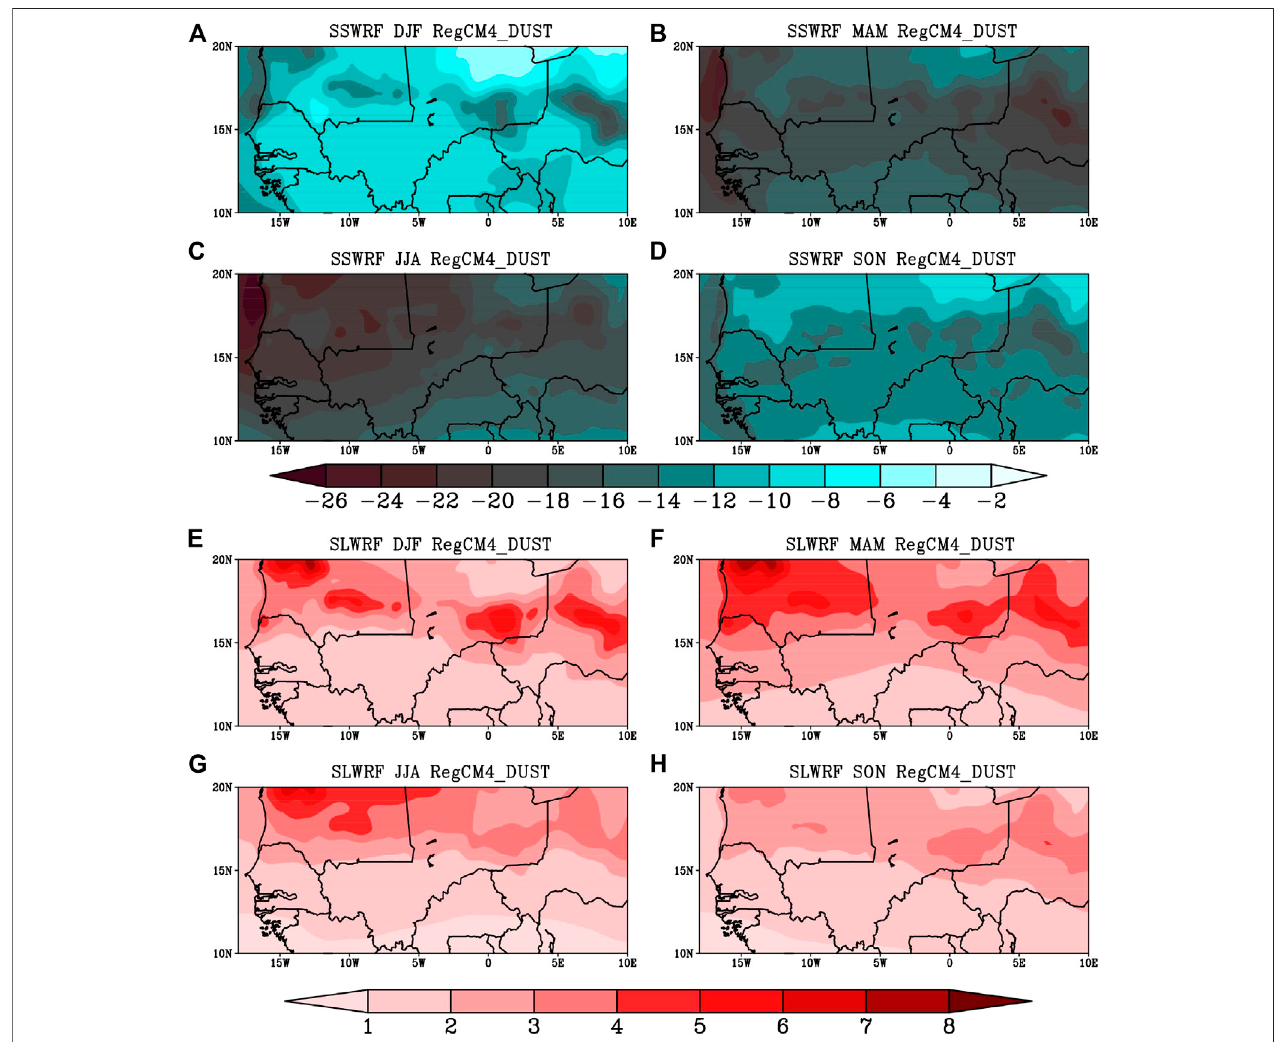
FIGURE 3 | Seasonal variability of dust surface shortwave (SSWRF) and longwave (SLWRF) radiative forcing (unit W/m 2 ) averaged from 2001 to 2010 over the Sahel for the RegCM4_DUST model (dust version).